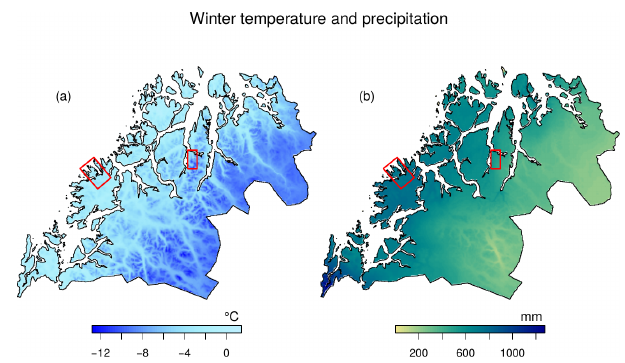
Figure 2. Mean winter temperature and total winter precipitation averaged over the period